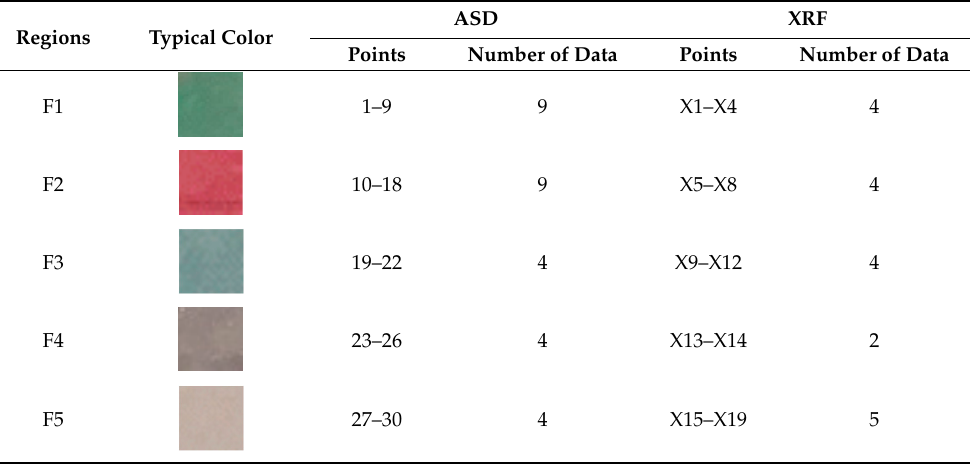
Table 8. Five regions of interest and sample numbers on the fresco. Regions Typical Color ASD